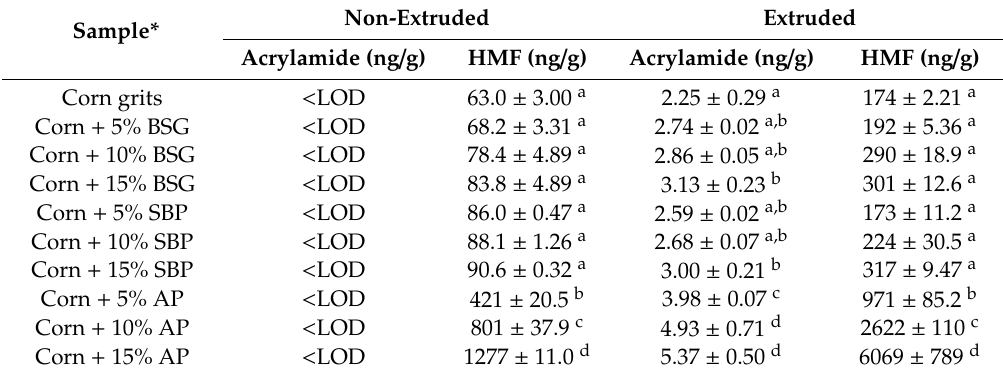
Table 3. Acrylamide and HMF contents in non-extruded and extruded